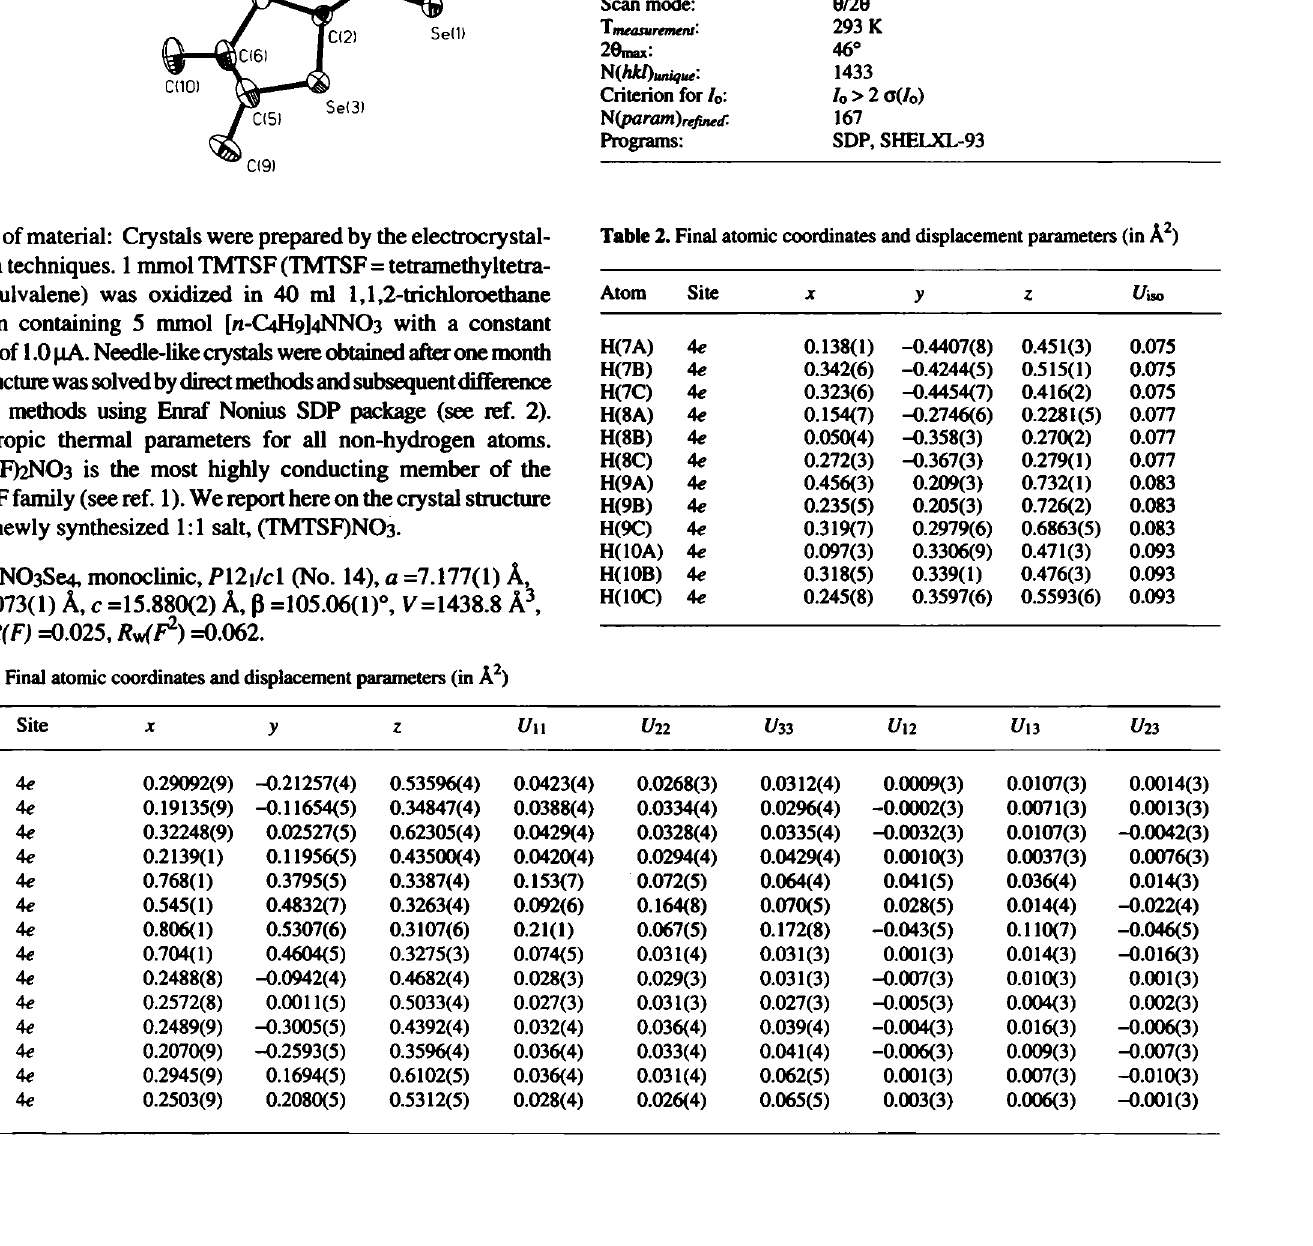
Table 1. Parameters used for the X-ray data collection Crystal: